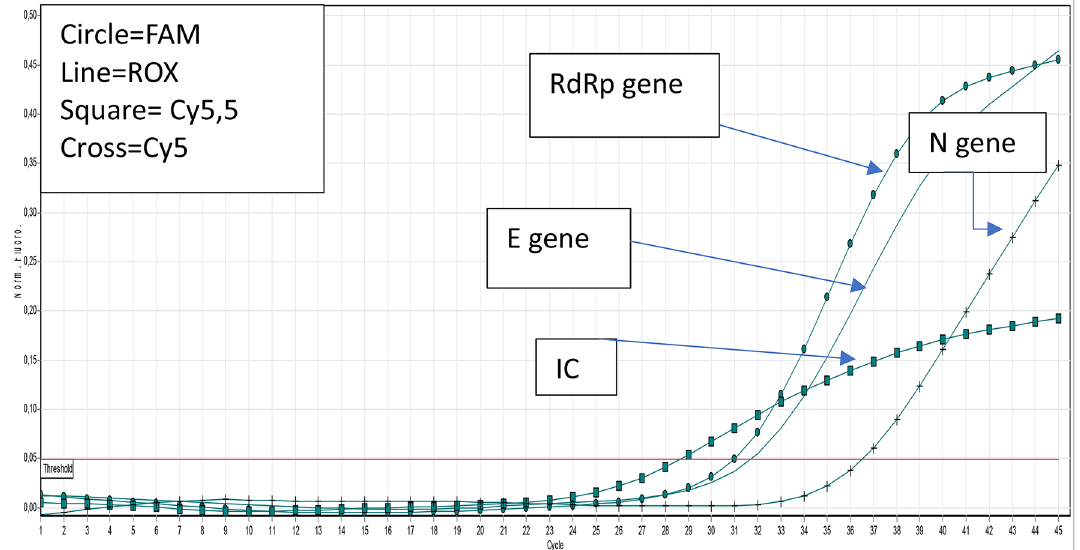
Figure 1. The figure illustrates the Real Time PCR curves of the genes detected by our kit; RdRp gene: RNA- dependent RNA polymerase gene; E: the envelope gene; N: the nucleocapsid gene; S: spike gene of COVID-19.